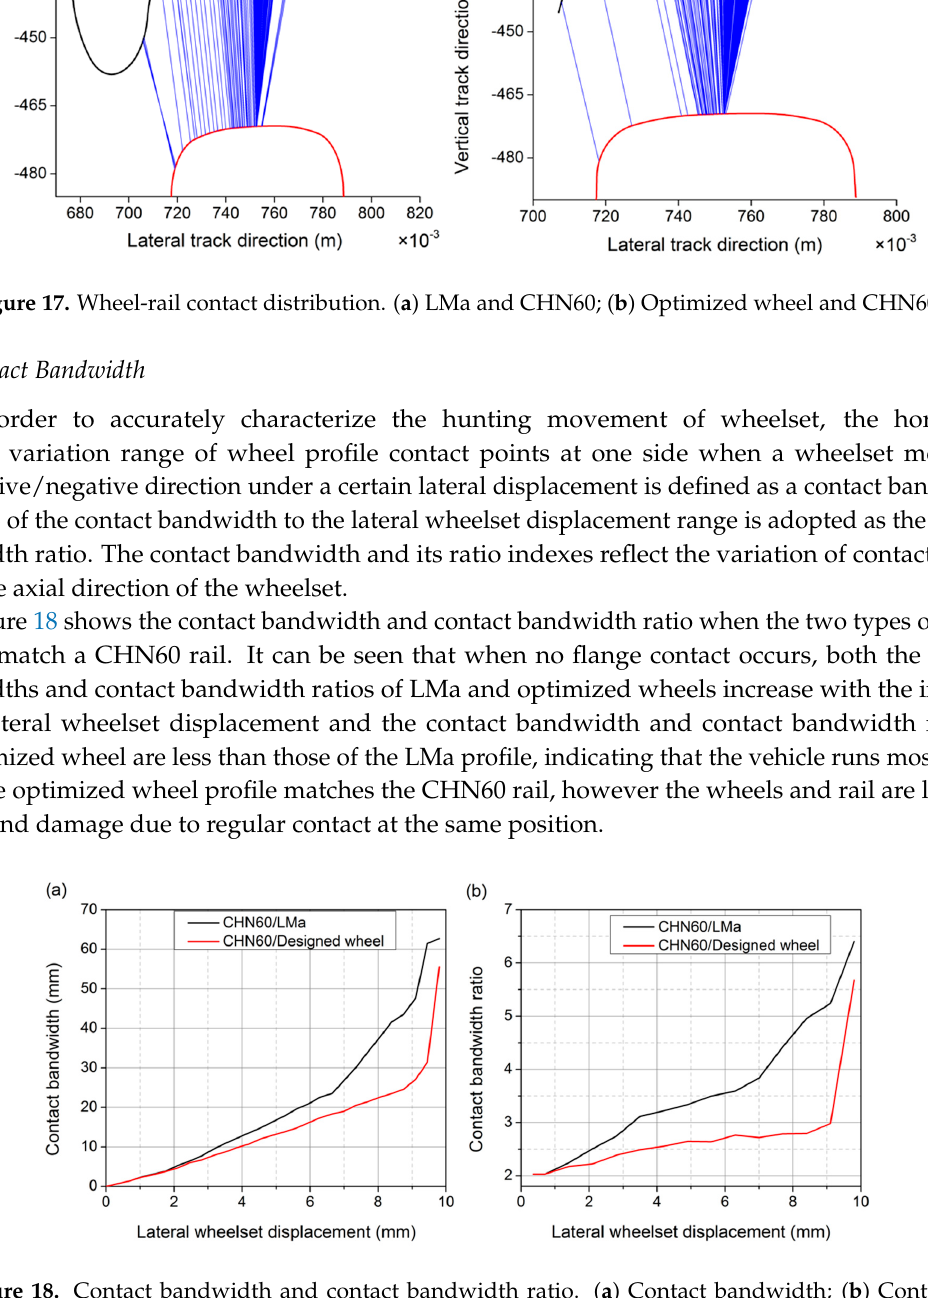
Figure 17. Wheel-rail contact distribution. ( a ) LMa and CHN60; ( b ) Optimized wheel and CHN60.